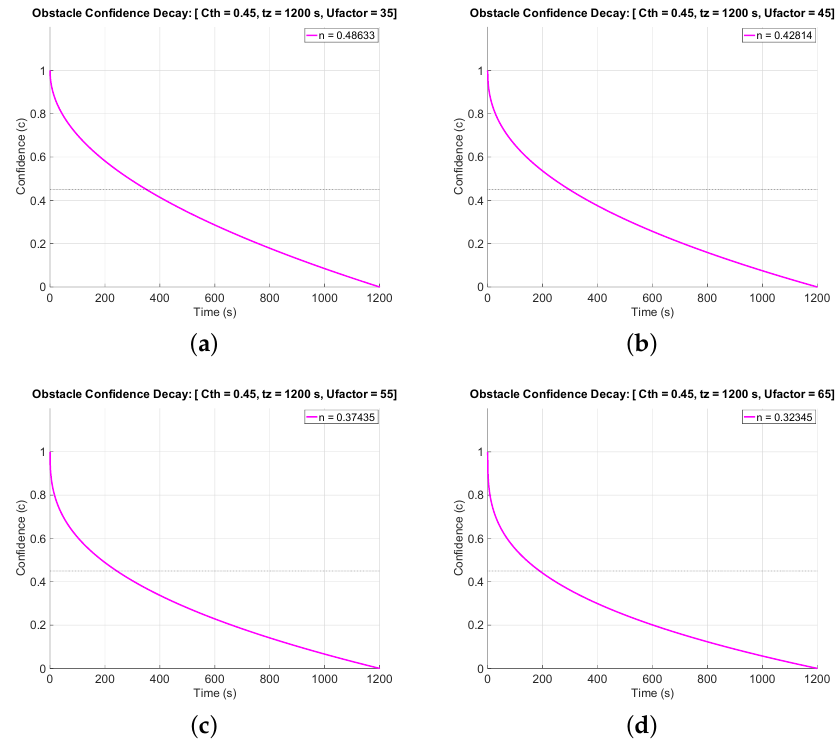
Figure 15. Estimation of confidence decay curve for different values of positional uncertainty with C th = 0.45 and t z = 1200 s. ( a ) Ufactor = 35%. ( b ) Ufactor = 45%. ( c ) Ufactor = 55%. ( d ) Ufactor = 65%. It can be seen that for higher uncertainties, the curve decays faster as